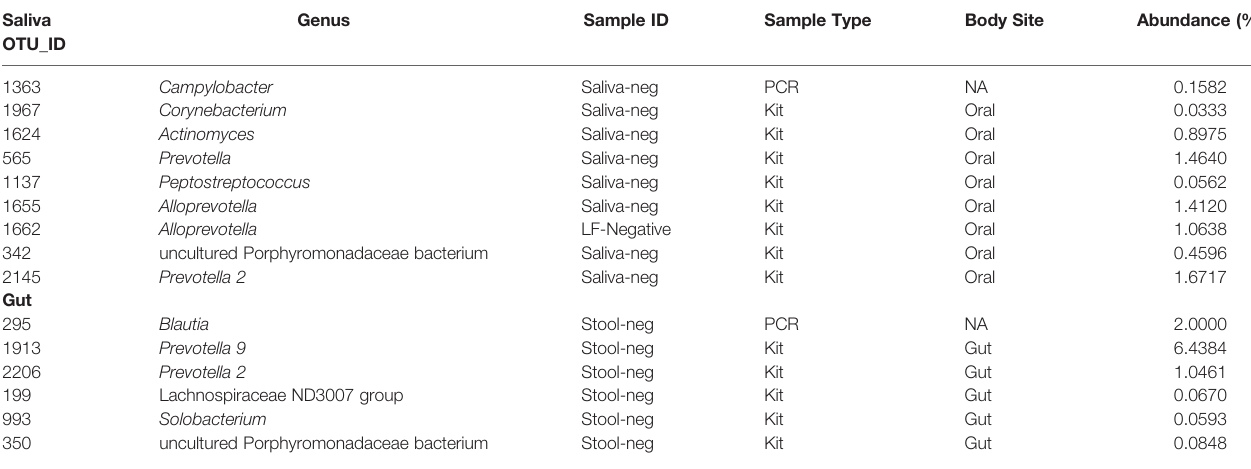
TABLE 2 | Summary of bacteria genera of differentially abundant bacteria genera which appeared signi fi cant in ALDEX2 analysis and appeared in the negative controls. Saliva